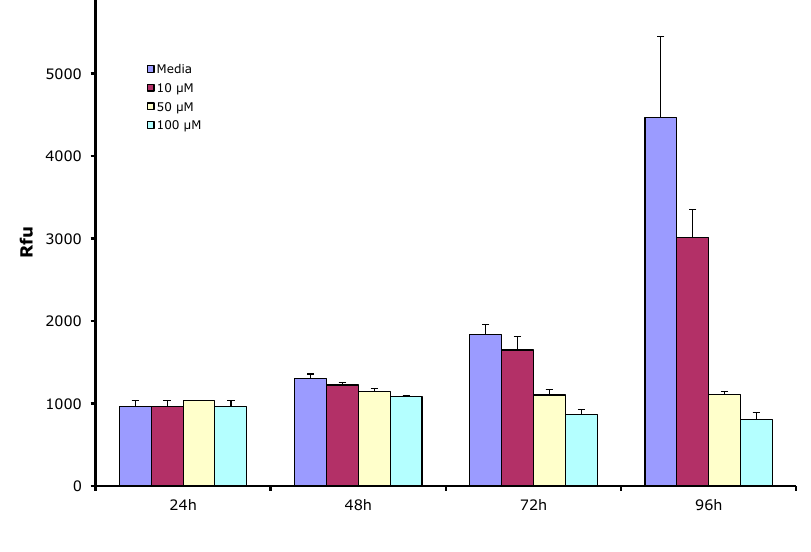
Figure 6. Resveratrol inhibits choroidal endothelial cell growth. Cells were grown in 96-well plates and treated with different concentrations of resveratrol or vehicle control. At 1–4 days, cells were incubated with CellTiter Blue and fluorescence measured.